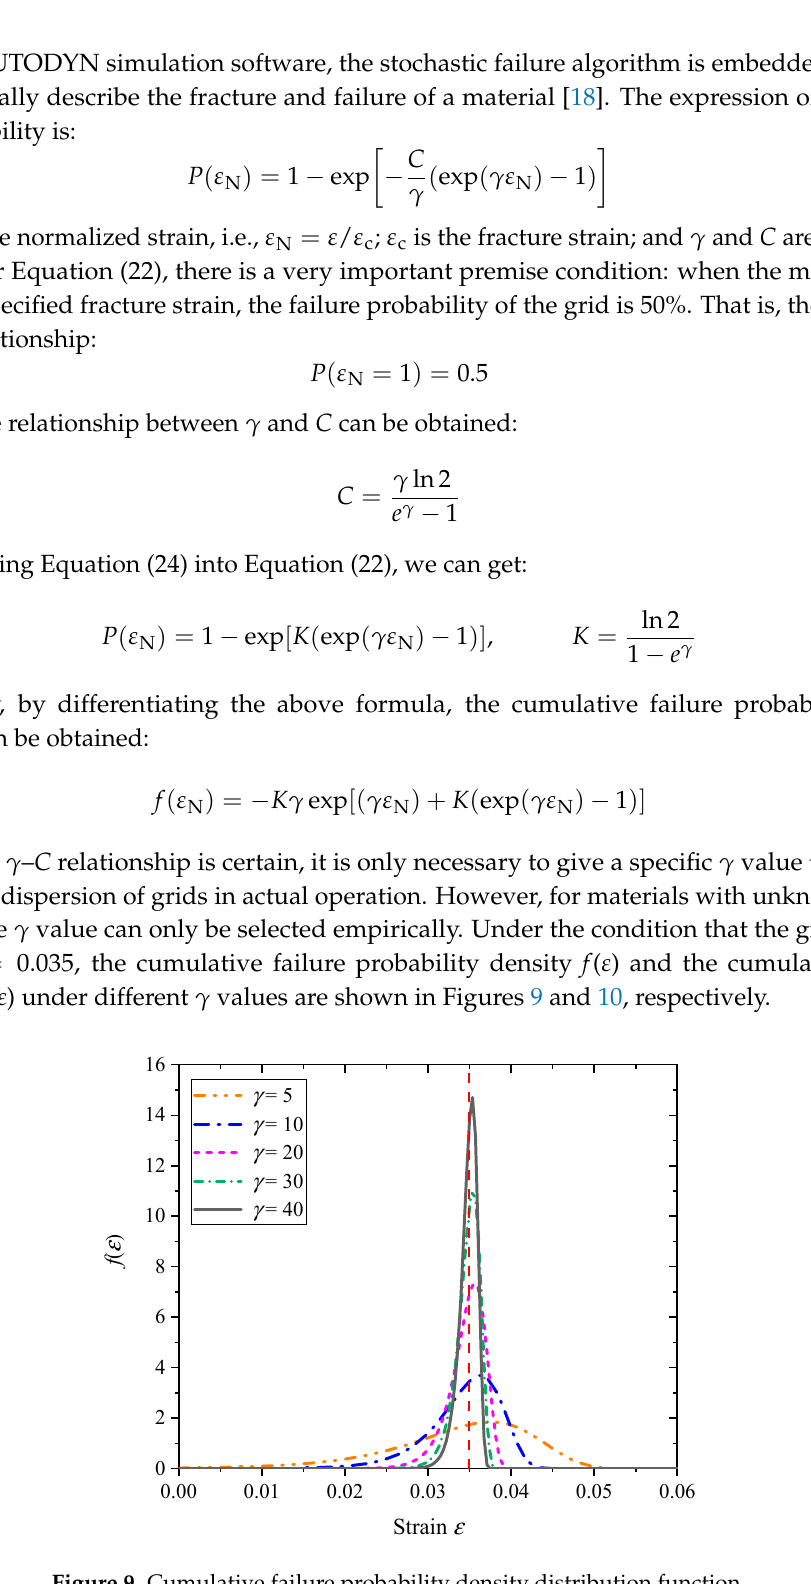
Figure 9. Cumulative failure probability density distribution function.